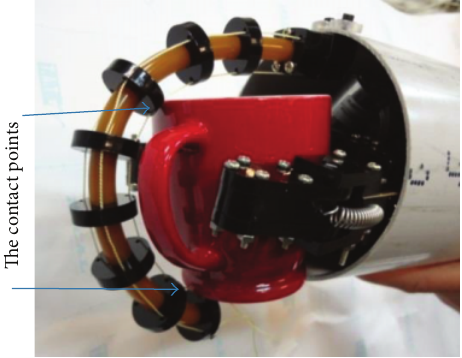
Figure 1: Object grasping by KNTU